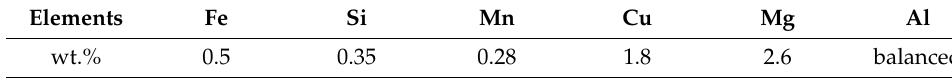
Table 2. Chemical composition of 2218 aluminum alloy substrate.